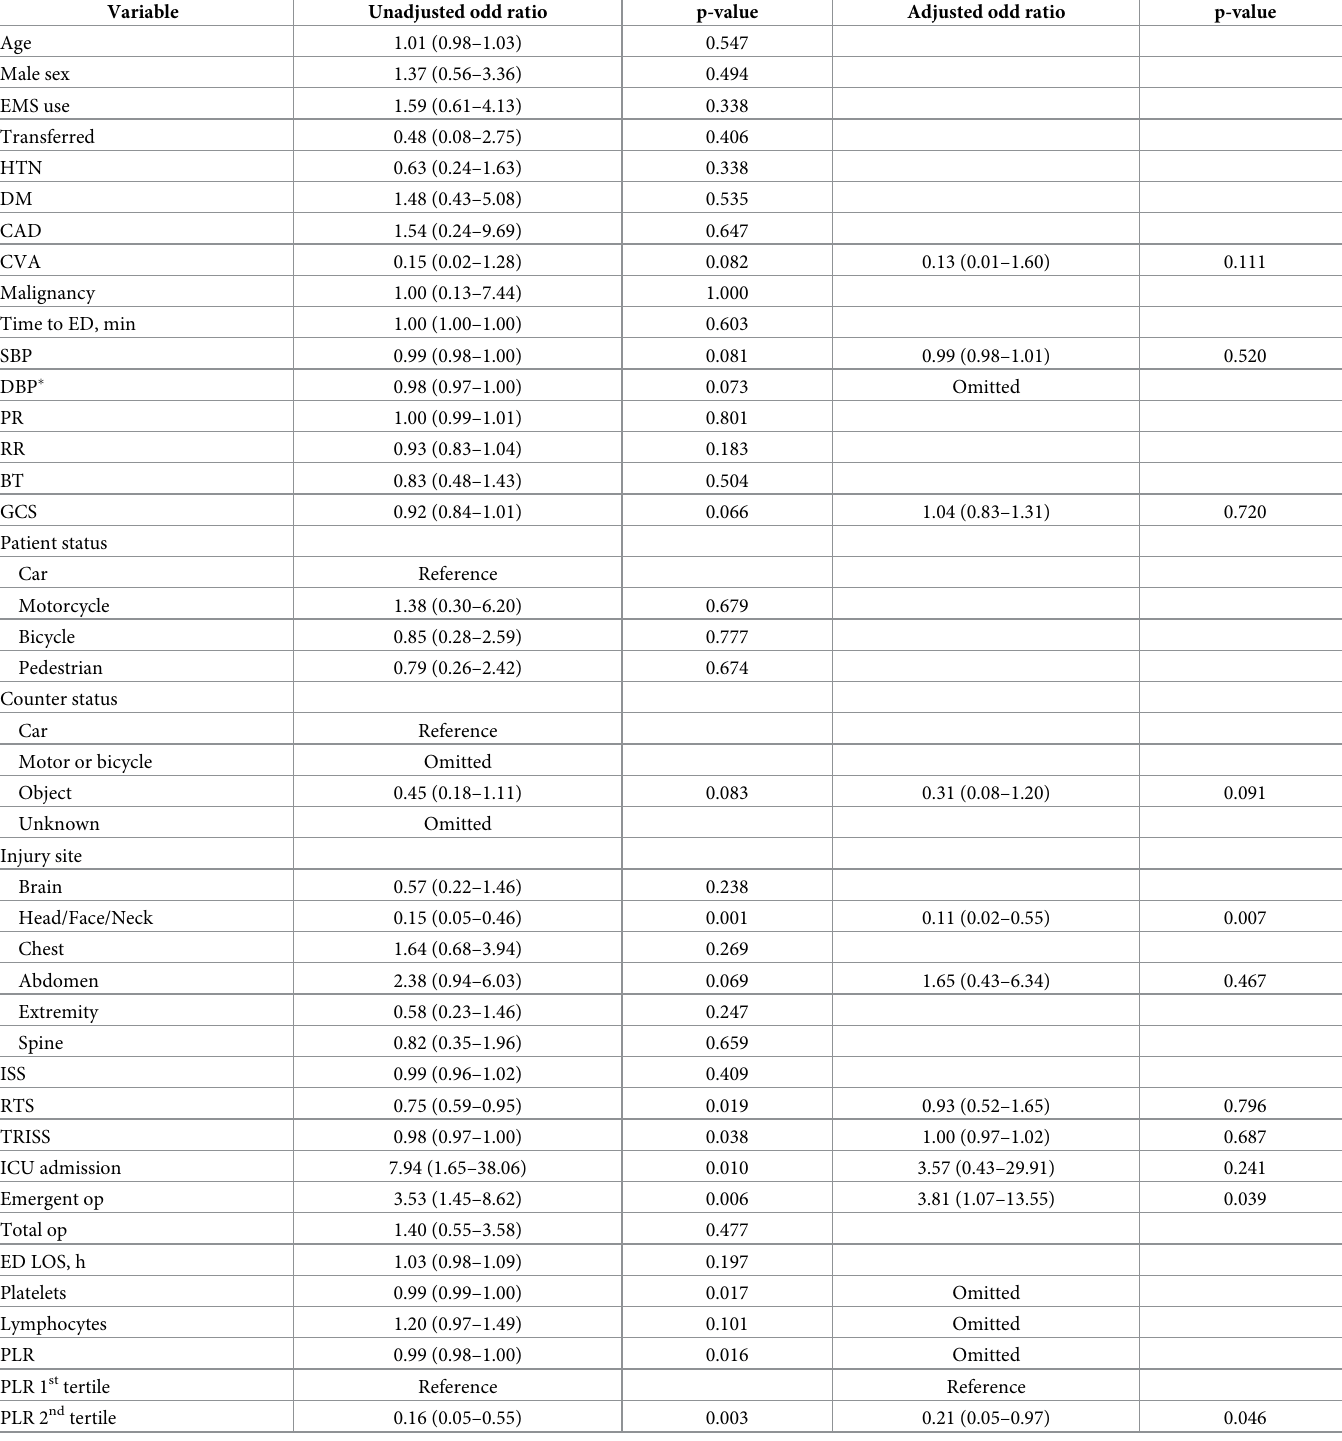
Table 3. Logistic regression analysis of the 1:1 propensity score matched